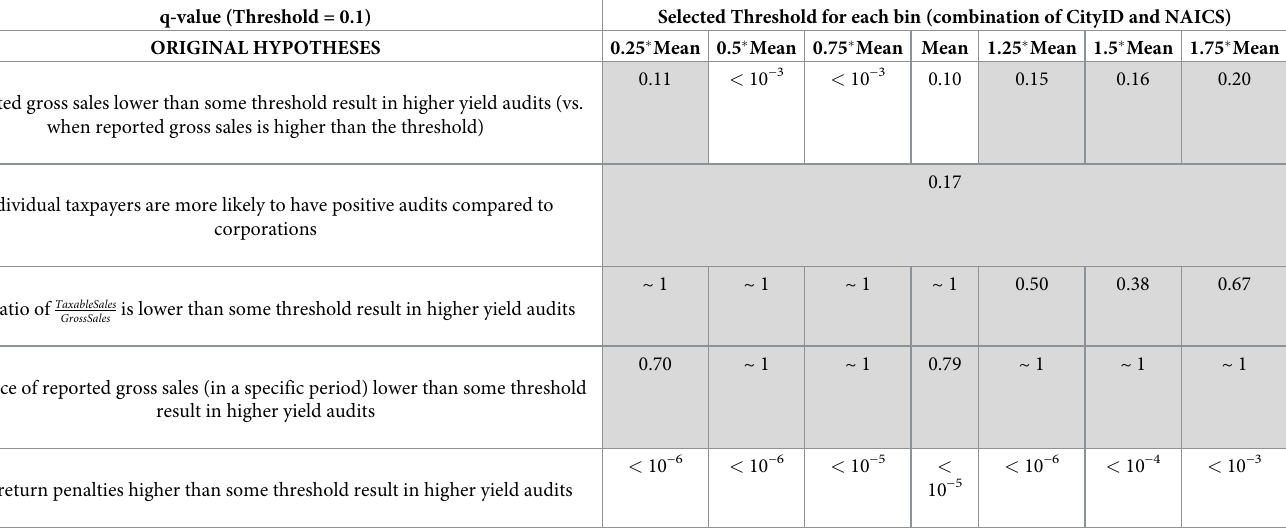
Table 1. Tax audit empirical hypotheses validation. q-value (Threshold = 0.1)